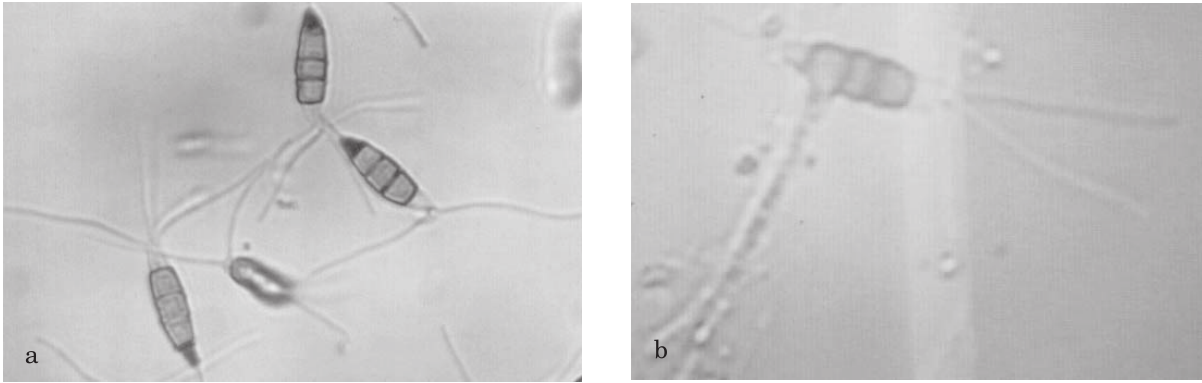
Fig. 2. (a) Conidia of Pestalotia subcuticularis ; (b) germinated conidia.